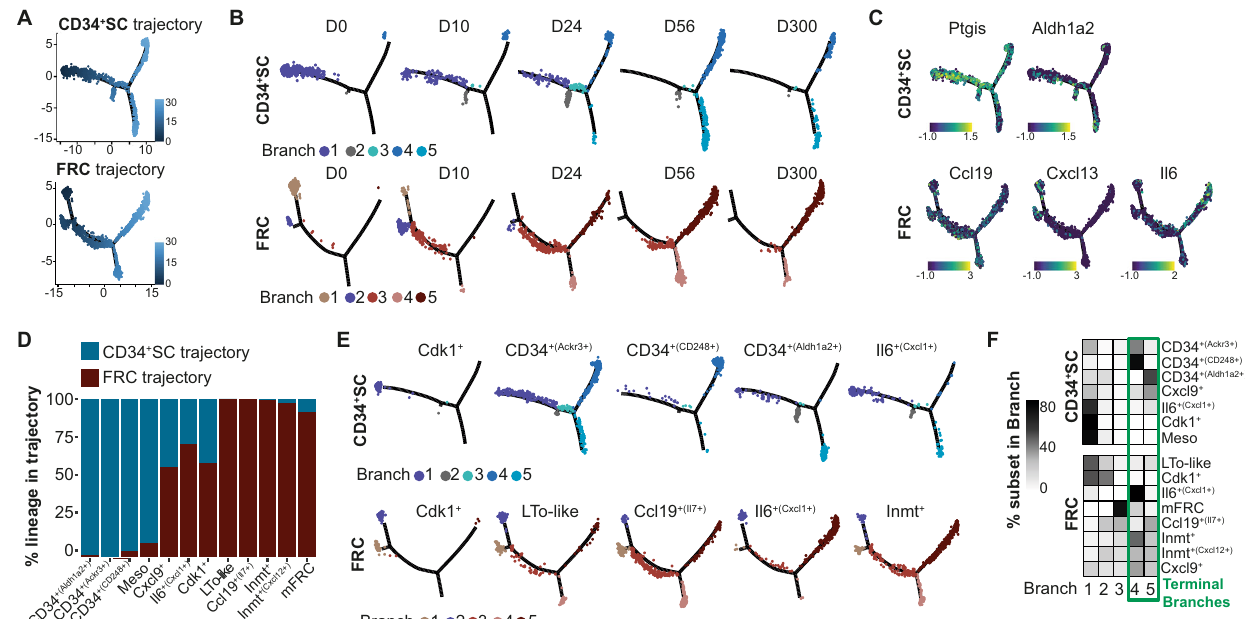
Fig. 2 | Distinct postnatal progenitors give rise to FRCs and CD34 + SCs. CD45 - CD24 - cells were isolated from mLNs of day 0, 10, 24, 56, and 300 old SPF-housed mice and subjected to scRNA-seq. One replicate was performed for day 0, 10, 24, and300timepoints,andtworeplicatesweregeneratedforday56timepoint.Non- endothelial SCs were identi fi ed as non-LECs, non-BECs, and non-PvCs. A Pseudotime ordering of FRCs and CD34 + SCs. B Pseudotime trajectories super- imposed with cells per time point. C Gene expression on pseudotime trajectories.